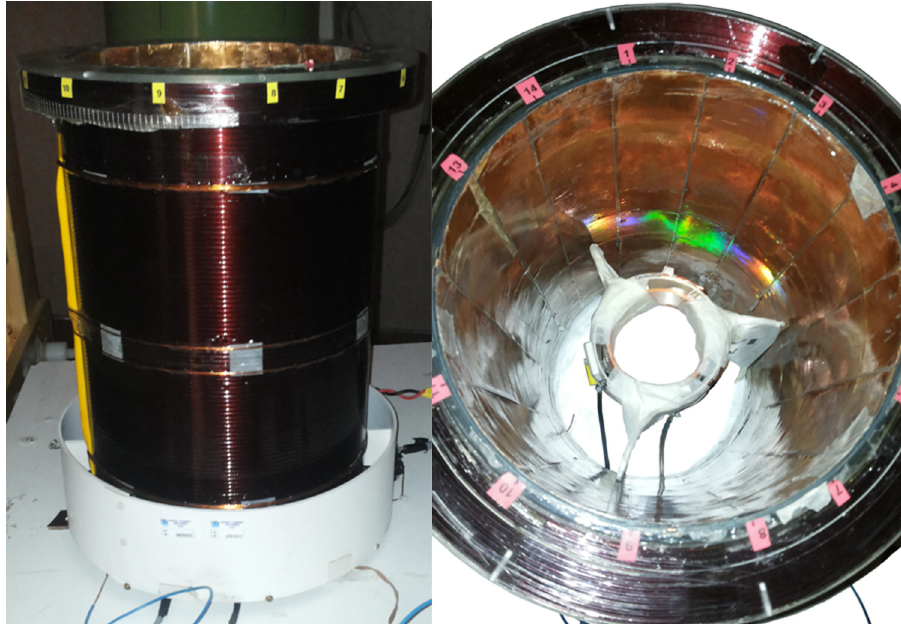
Fig 1. The VLF-MRI coil system. The main compensated solenoid with G z gradient coils (left) and the RF coils placed inside the magnet bore (right).